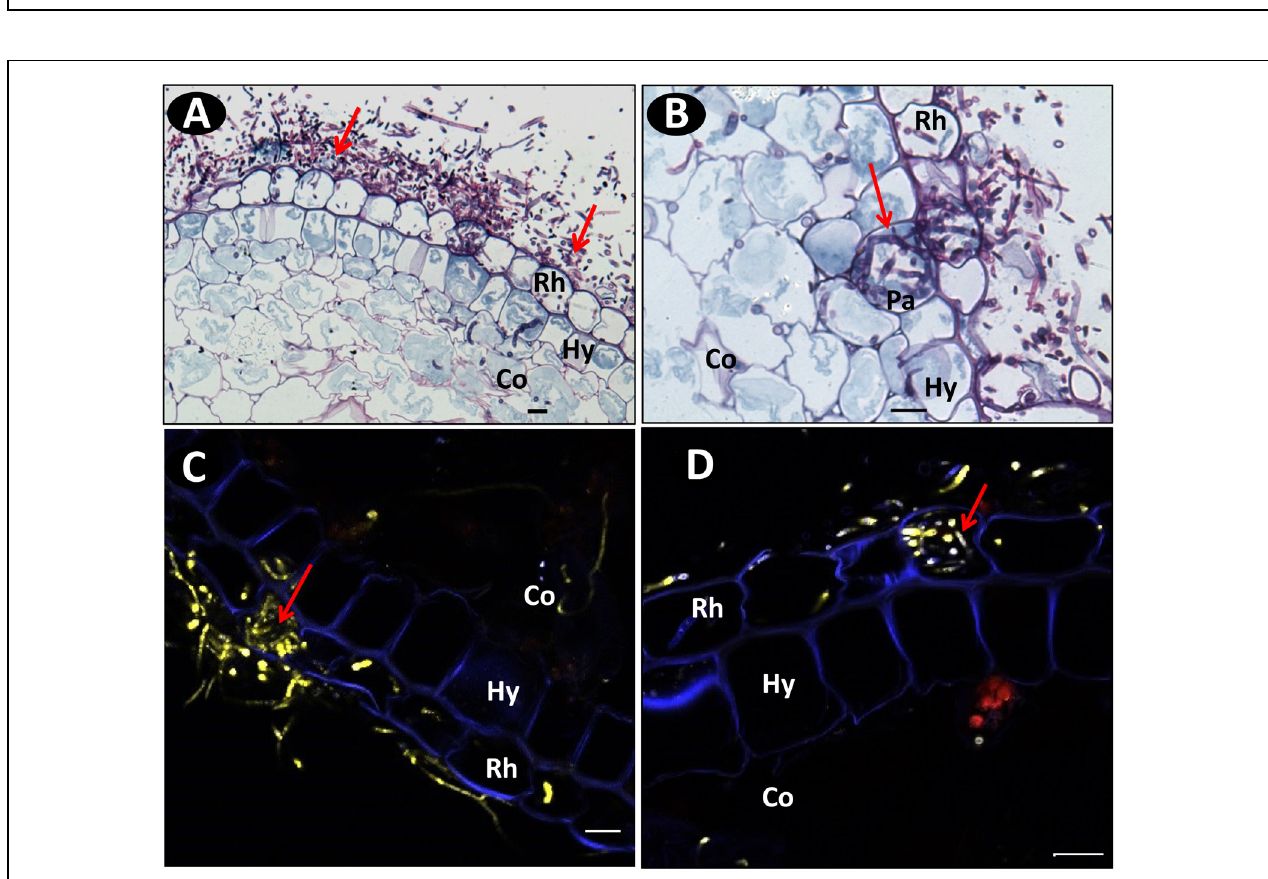
Frontiers in Plant Science | www.frontiersin.org